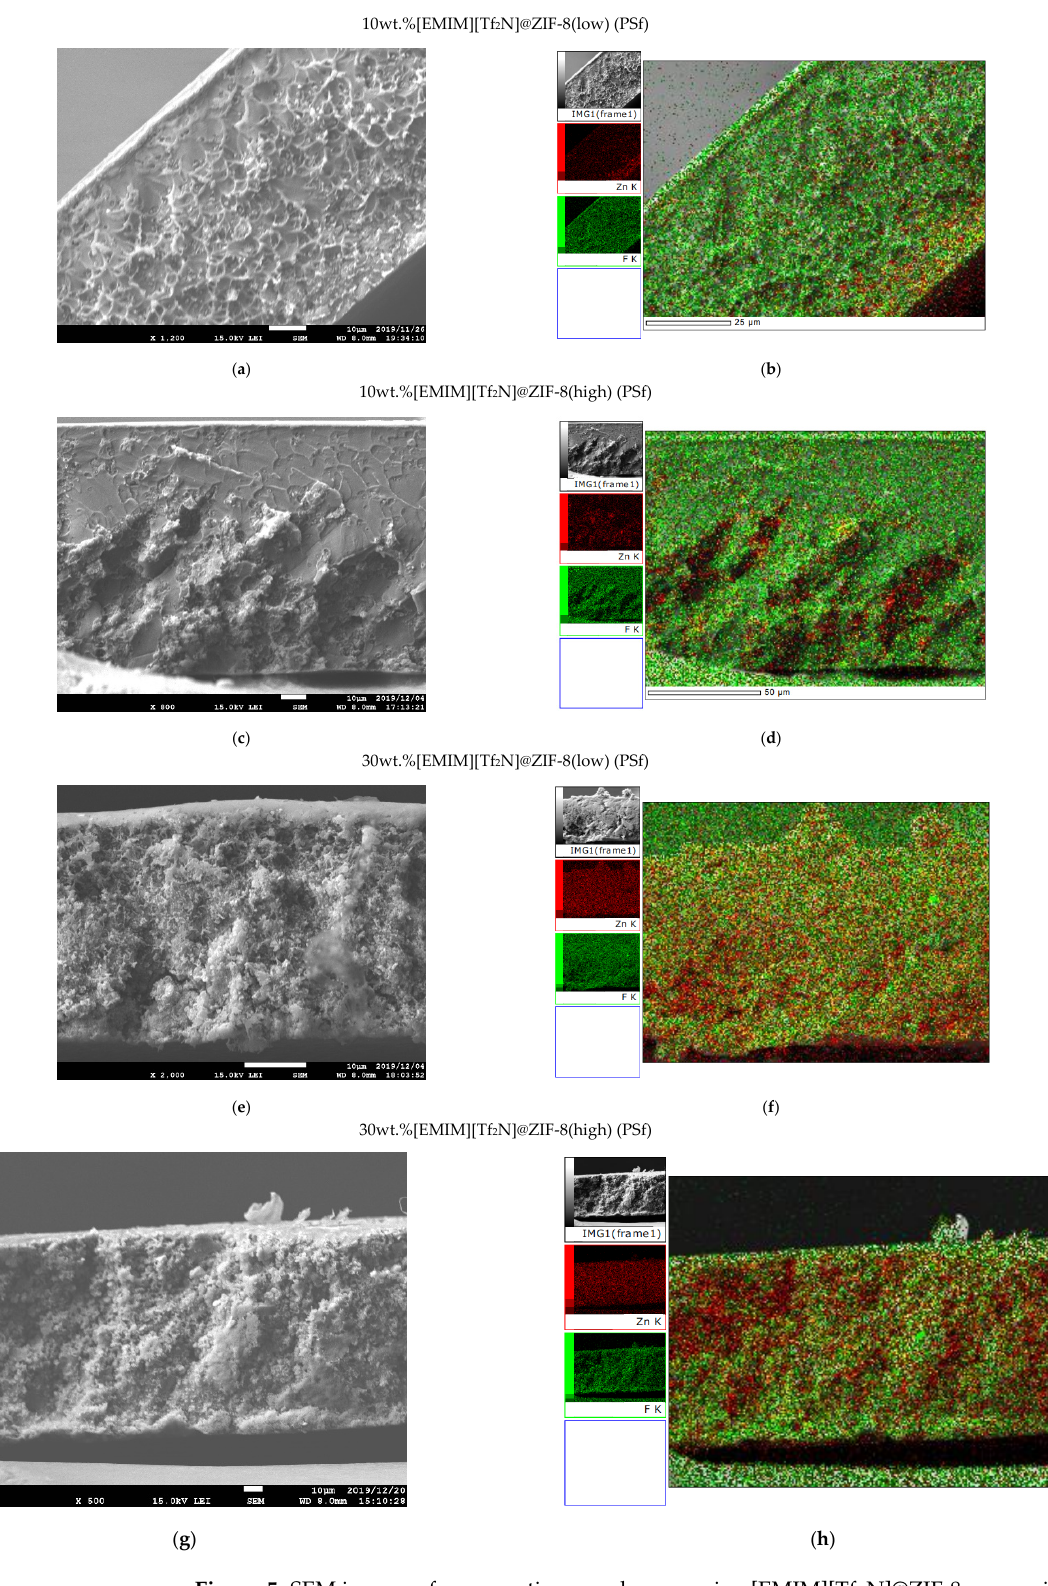
Figure 5. SEM images of cross-section membranes using [EMIM][Tf 2 N]@ZIF-8 composites, accompa- nied by EDS mapping ( a , b ) 10 wt.%[EMIM][Tf 2 N]@ZIF-8(low)(PSf); ( c , d ) 10 wt.%[EMIM][Tf 2 N]@ZIF- 8(high) (PSf); ( e , f ) 30 wt.%[EMIM][Tf 2 N]@ZIF-8(low)(PSf); and ( g , h ) 30 wt.%[EMIM][Tf 2 N]@ZIF- 8(high) (PSf).